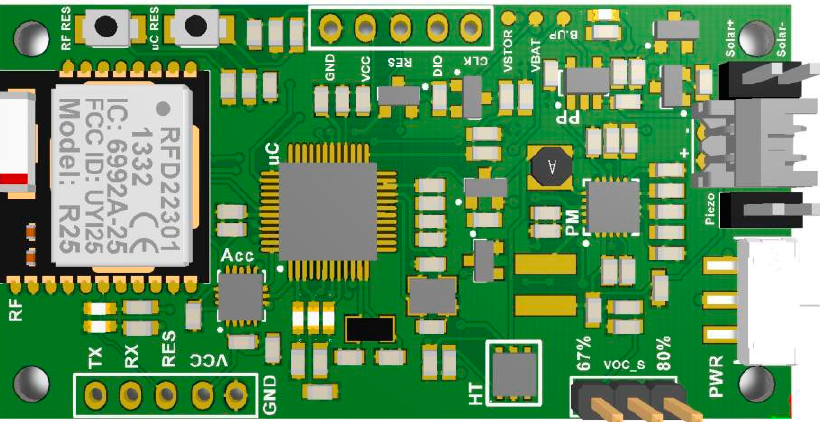
Figure 1. Block diagram of the components of the vibration analyser.